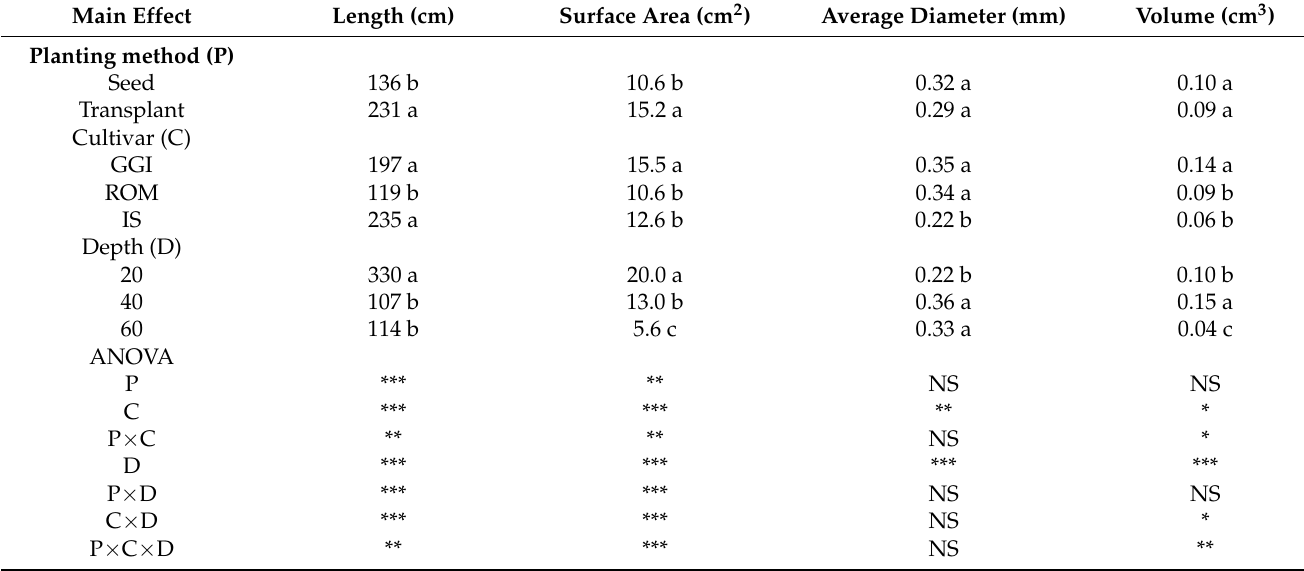
Table 2. Root trait components of artichoke cultivars (Green Globe Improved (GGI), Romolo (ROM), and Imperial Star (IS)) as influenced by planting method (direct seeding—Seed, and transplanting—Transplant) and soil depth during the harvesting period, July 2015.